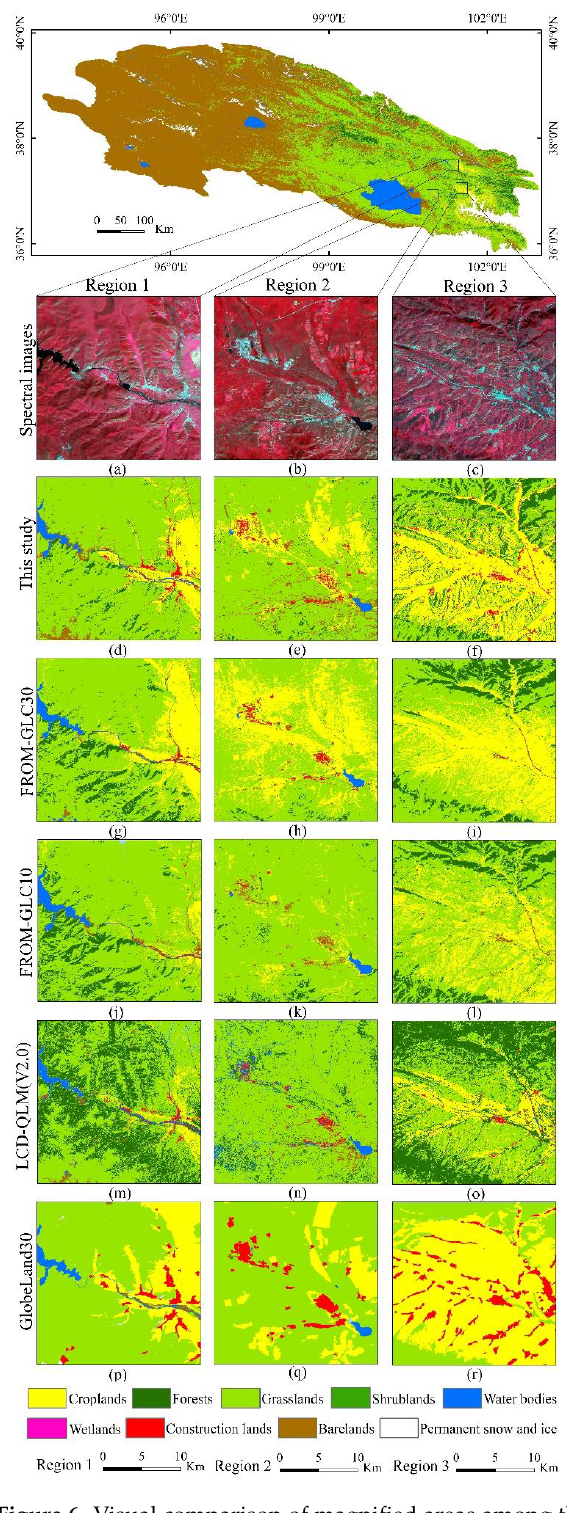
Figure 6. Visual comparison of magnified areas among the classification results in this study and existing high-spatial resolution land cover products. ( a – c ) the standard false-color composited images of three regions; ( d – f ) the magnified display of the classification results obtained in this study; ( g – i ) the magnified display of the FROM-GLC30; ( j – l ) the magnified display of the FROM-GLC10; ( m – o ) the magnified display of the LCD-QLM (V2.0); ( p – r ) the magnified display of the